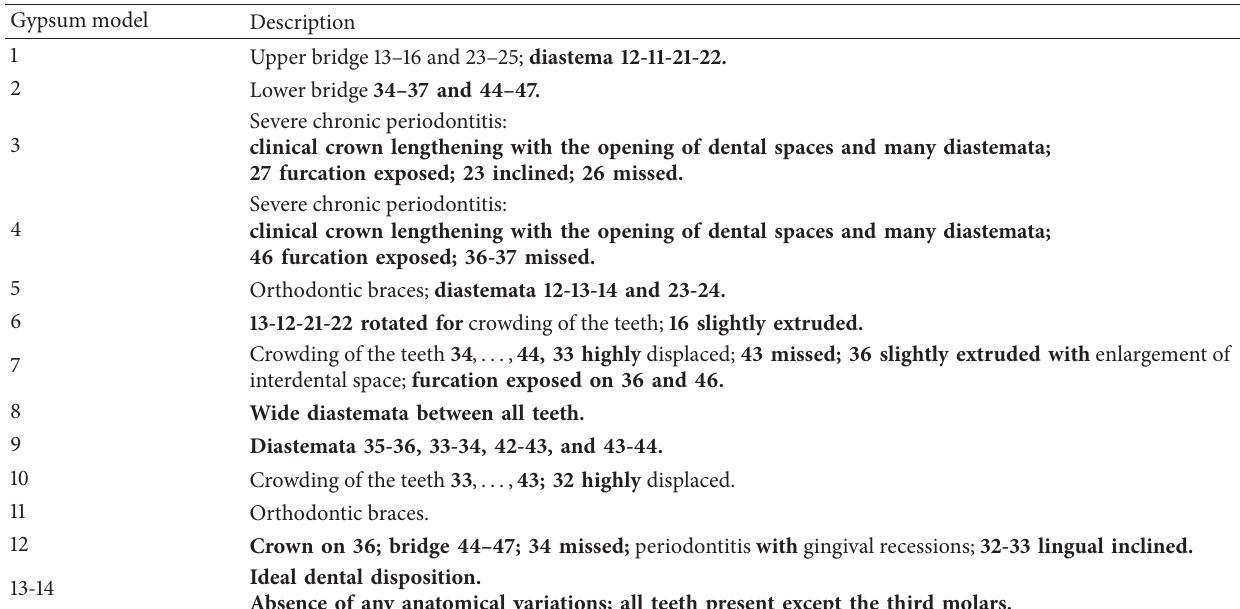
Table 1: Description of each tested model.